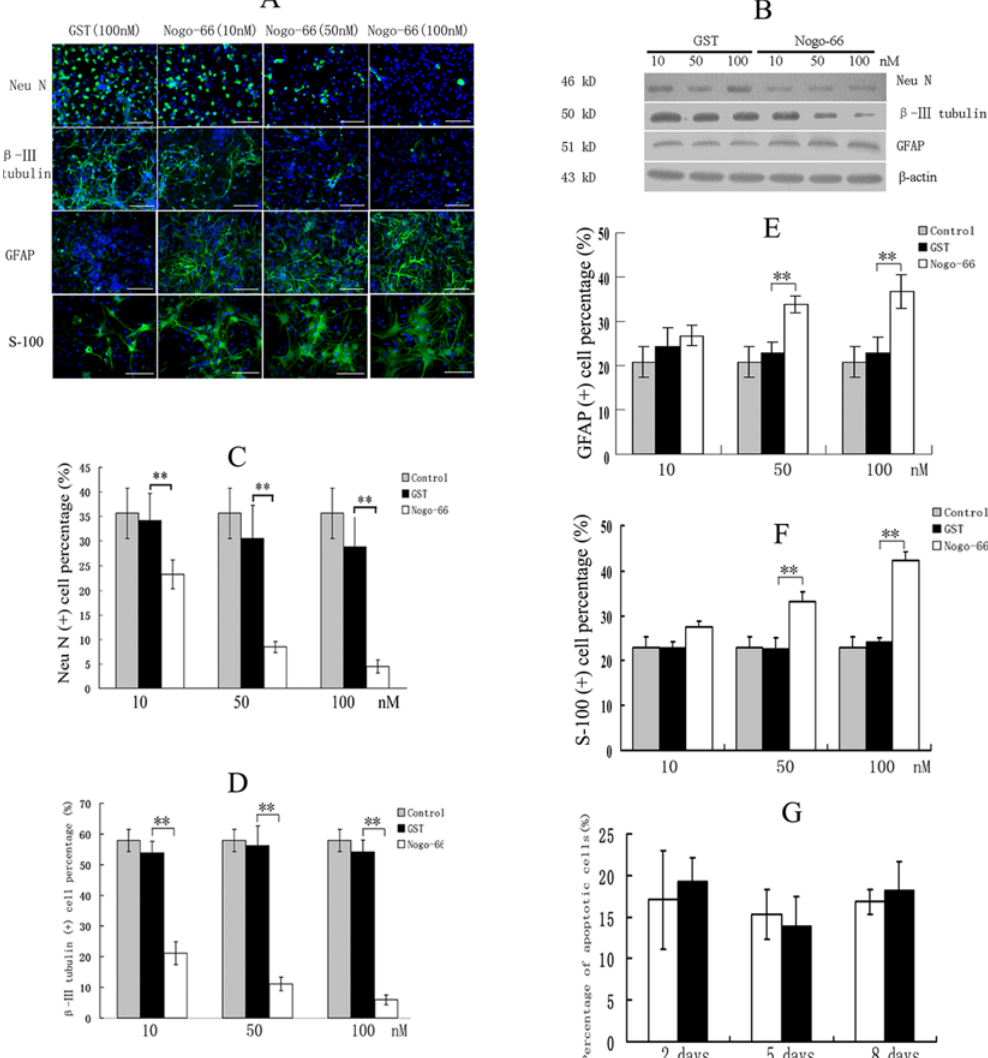
Figure 3. Astroglial induction of NPCs by Nogo-66 for 8 days. (A) Images of immunocytochemistry. (B) In western blot analysis, both NeuN and b III tubulin expressions were decreased and GFAP was upregulated in NPCs induced by Nogo-66. (C, D) The quantitative results of anti-NueN, and b III tubulin antibodies immunocytocheminstry. Nogo-66 significantly inhibited neuronal differentiation in NPCs in dose-dependent manner. (E, F) The quantitative results of anti-GFAP and S-100 b antibodies immunocytocheminstry. Nogo-66 significantly induced NPCs differentiation into astroglial cells in dose-dependent manner. (G) Apoptosis assay with Annexin V-Fitc and PI staining by FACS. Nogo-66 did not induce significantly apoptosis compared to GST at day 2, 5, and 8. Data are mean 6 S.E. Error bars indicate SE. * p , 0.05 ** p , 0.01(n=3). Bar scale=100